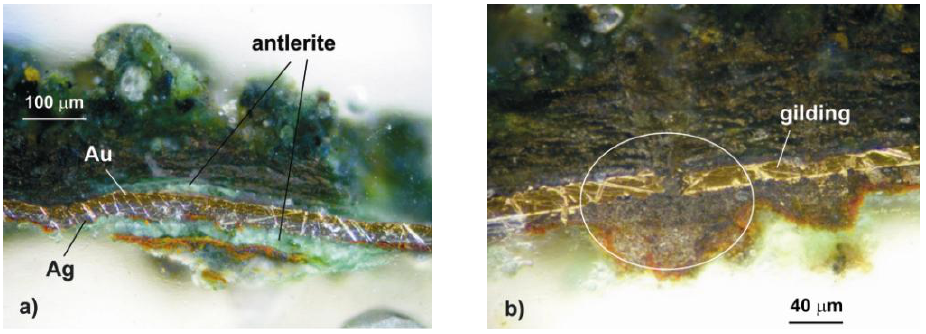
Figure 18. Cross sections of micro-samples from point 1 (Figure 15a): (a) presence of Ag and Au layers; (b) defect in the gilding layer accomplished by a large growth of corrosion products.